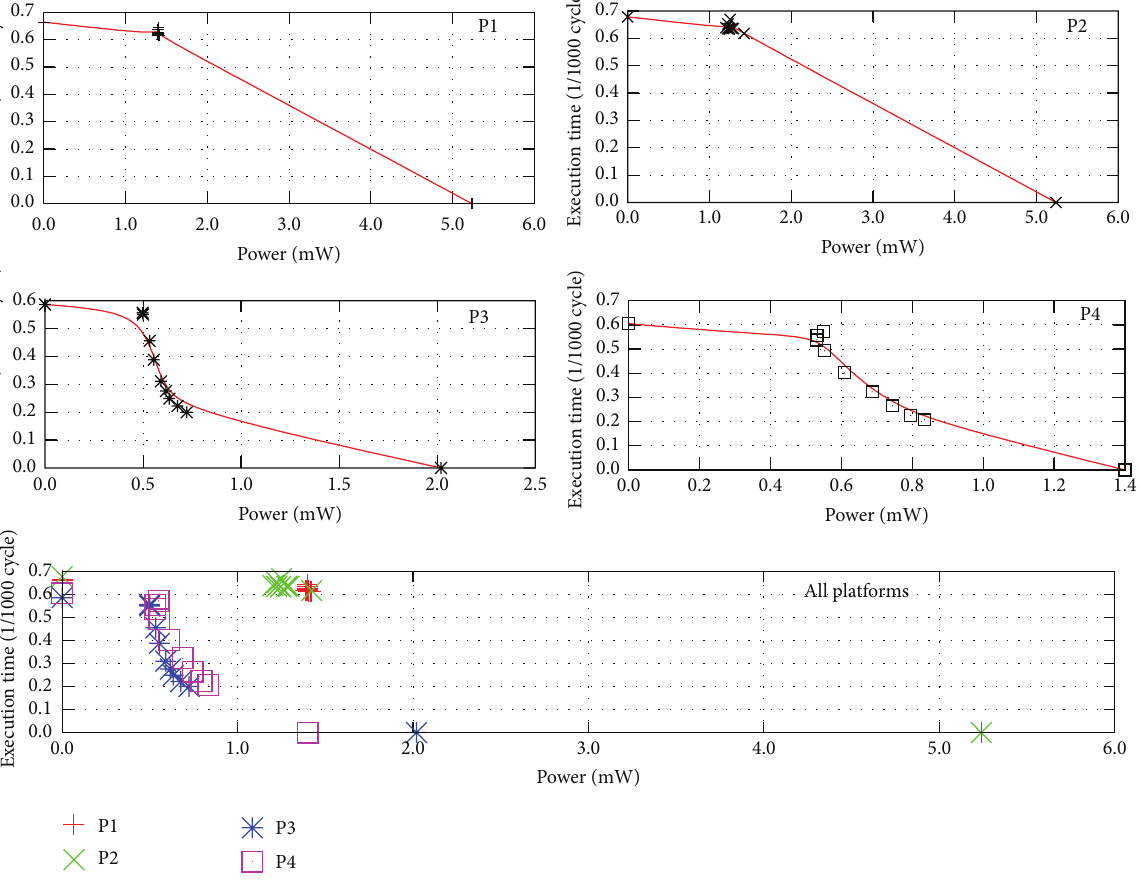
Figure 16: Aggregated Pareto front (time versus power) for MediaBench benchmark (DFG16).